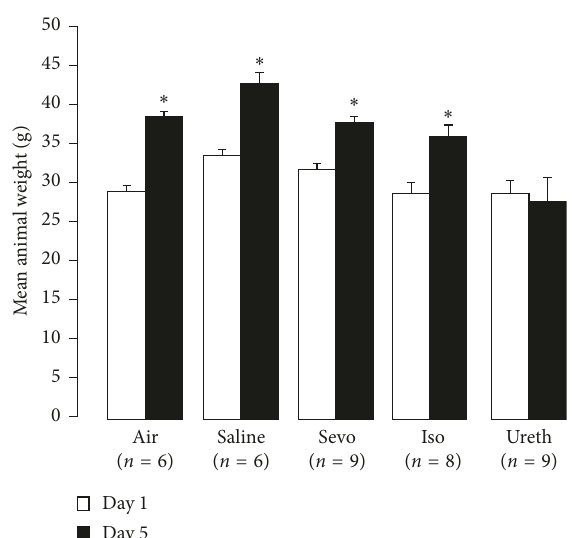
Figure 1: Animal weights on day 1 and day 5 after anesthetic ex- posure. The indicated treatments were administered in a single dose to PD15 rats for 4 hours (for inhalational agents) or as a single IV bolus (urethane), as indicated in Methods. Data represent mean SEM, with the number of animals indicated on the graph. Control animals were treated with air or saline, depending on the delivery ± route. Symbols indicate day 5 values that differ significantly from the day 1 values for that group ( P 0 . 05). Only the urethane-treated animals failed to gain weight over the analysis period. Iso: isoflurane; Sevo: sevoflurane; Ureth: <